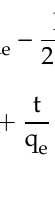
Figure 7. The comparison of MB adsorption capacity, O content ( a ) and surface area ( b ) in the carbon materials before and after air activation.